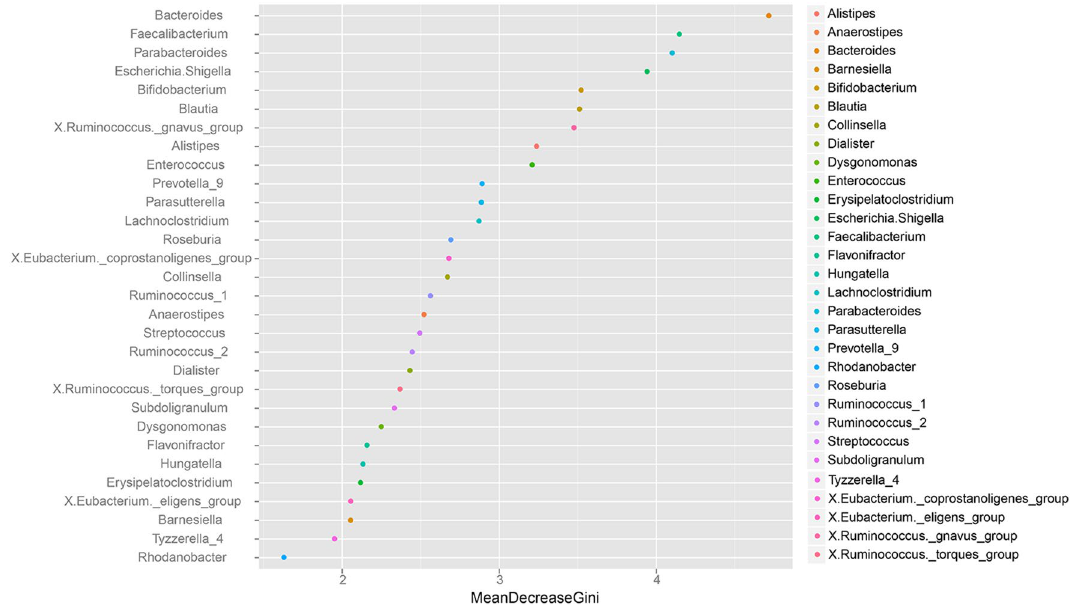
Figure 4. Two indexes, namely, the mean decrease in Gini, was calculated with a trained “random forest” model, which revealed the essential genera that triggered the difference among healthy child, child with nonwheezing MPP, and child with wheezing